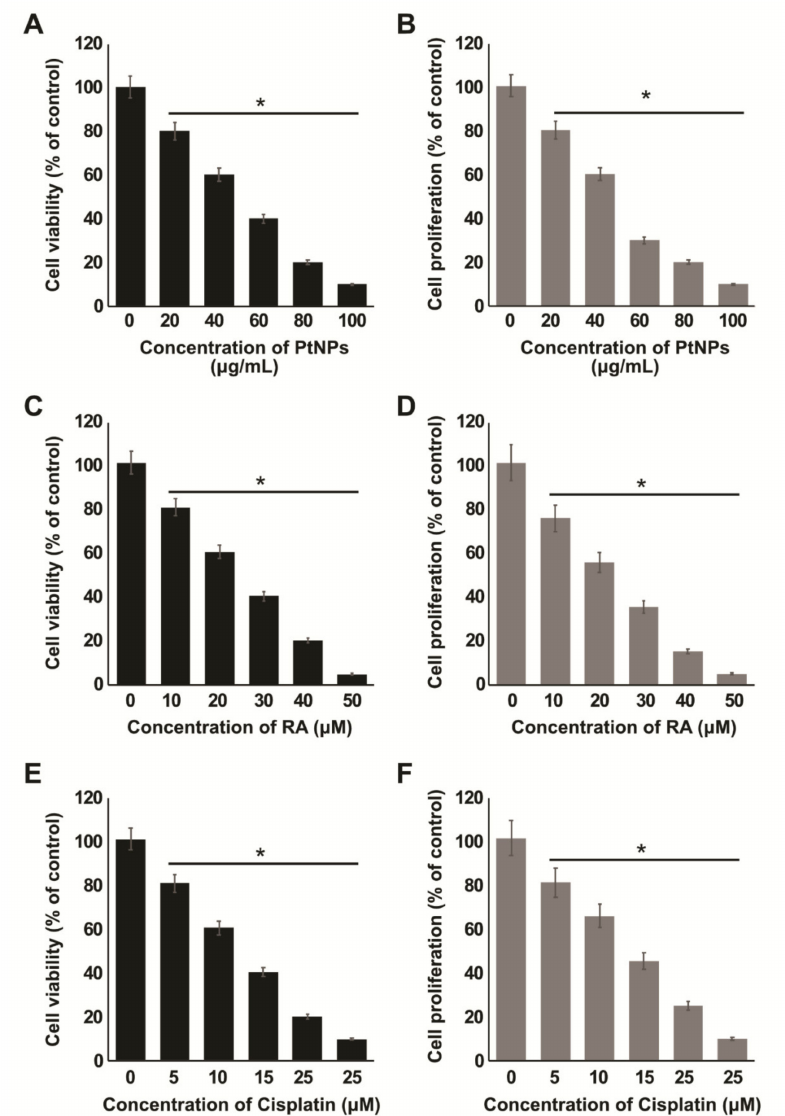
Figure 3. Dose-dependent e ff ect of PtNPs, RA, and cisplatin on cell viability and proliferation of SH-SY5Y cells. The viability of SH-SY5Y cells was determined after 24-h exposure to di ff erent concentrations of PtNPs (20–100 µ g / mL) ( A ). Proliferation of SH-SY5Y cells was determined using the BrdU assay after 24-h exposure to di ff erent concentrations of PtNPs (20–100 µ g / mL) ( B ). Viability of SH-SY5Y cells was determined after 24-h exposure to di ff erent concentrations of RA (10–50 µ M) ( C ). Proliferation of SH-SY5Y cells was determined using the BrdU assay after 24-h exposure to di ff erent concentrations of PtNPs (10–50 µ M) ( D ). Viability of SH-SY5Y cells was determined after 24-h exposure to di ff erent concentrations of cisplatin (5–25 µ M) ( E ). Proliferation of SH-SY5Y cells was determined using the BrdU assay after 24-h exposure to di ff erent concentrations of cisplatin (5–25 µ g / mL) ( F ). The results are expressed as mean ± standard deviation of three independent experiments. The treated groups showed statistically significant di ff erences from the control group per the Student’s t -test; * p < 0.05 was considered significant. PtNPs, platinum nanoparticles; RA, retinoic